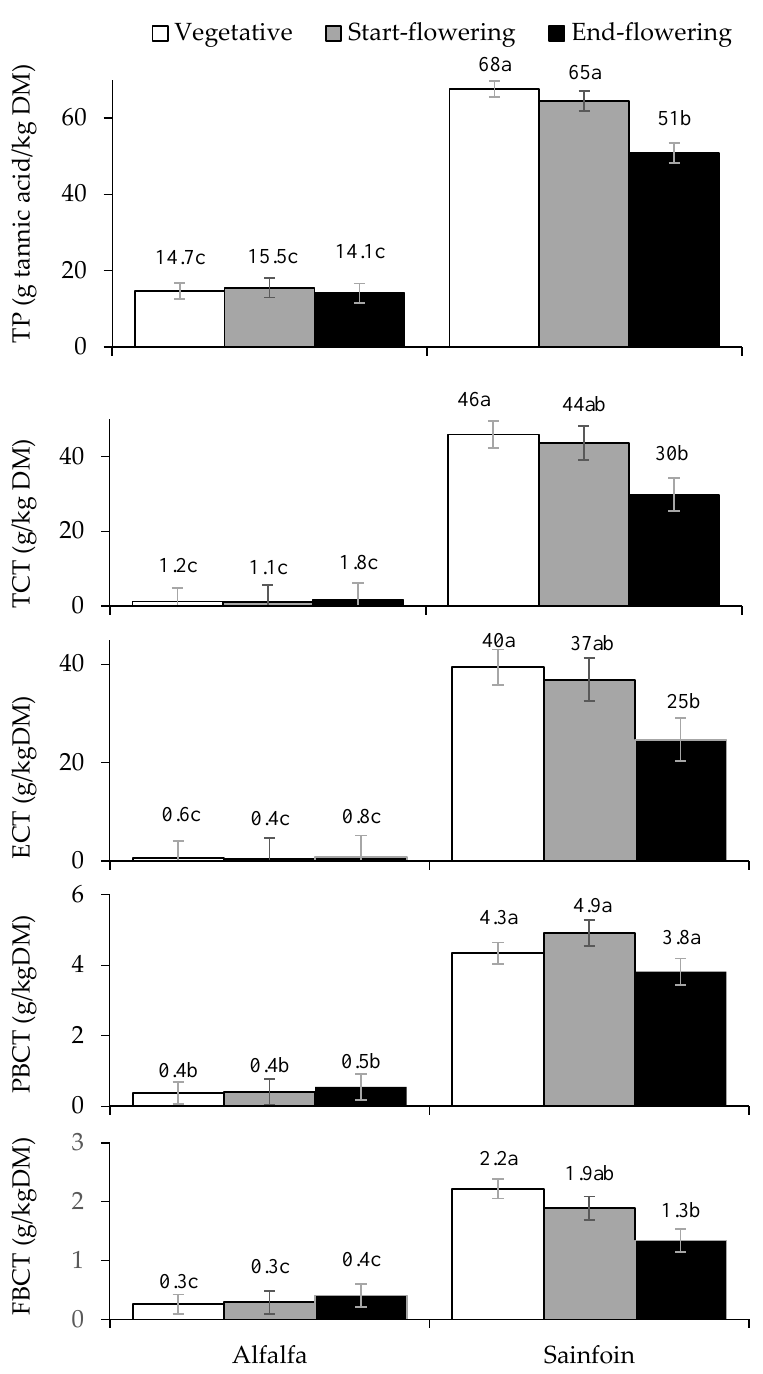
Figure 1. Effect of the species and the stage of maturity on the contents of total polyphenols (TP), total condensed tannins (TCT), extractable CT (ECT), protein-bound CT (PBCT), and fiber-bound (FBCT). Within a parameter, means with different letter differ at p < 0 . 05. (Within each species: n = 3 for the vegetative stage, n = 2 for the start-flowering, and n = 2 for the end-flowering stages.)